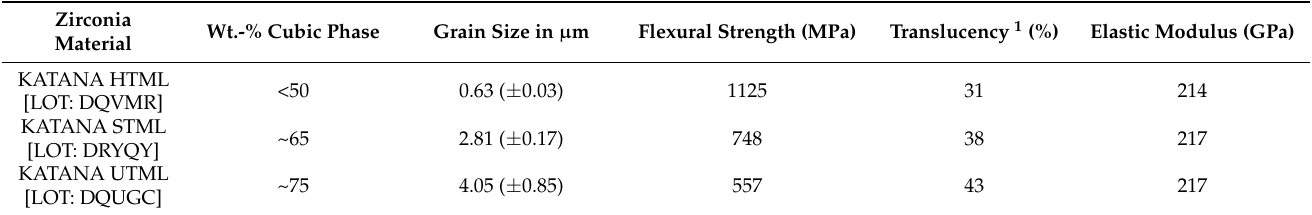
Table 1. Overview of tested Zirconia materials, LOT numbers and different properties according to the manufacturer’s information (Katana, Kuraray Noritake, Japan).